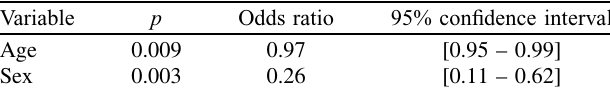
Table 3. Results of multivariate analysis of the association of atopy with variables found signi fi cant at p (cid:3) 0.15.